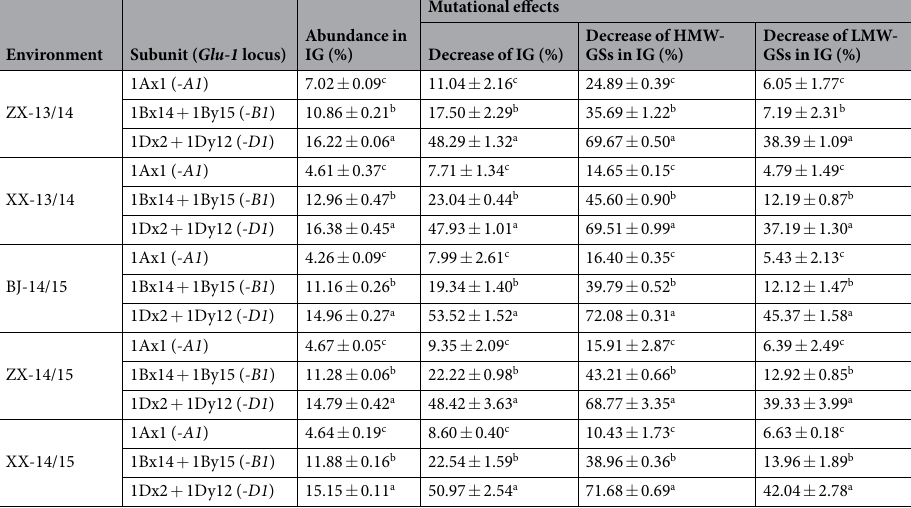
Table 4. Relative abundance in IG of the HMW-GSs encoded by Glu-A1 , -B1 or -D1 and their mutational effects in five environments a . a Each value is the mean ± SE of three separate tests. Different letters after the means indicate statistically significant difference ( P < 0.05). HMW-GSs, high-molecular-weight glutenin subunits; IG, insoluble glutenin; LMW-GSs, low-molecular-weight glutenin subunits.